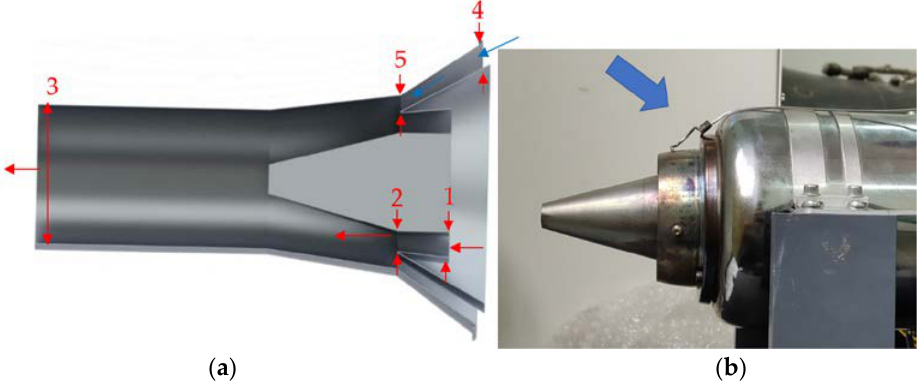
Figure 3. Scheme of the ejector for the Jet Cat P80 micromotor ( a ) and the nozzle of the micromotor ( b ).